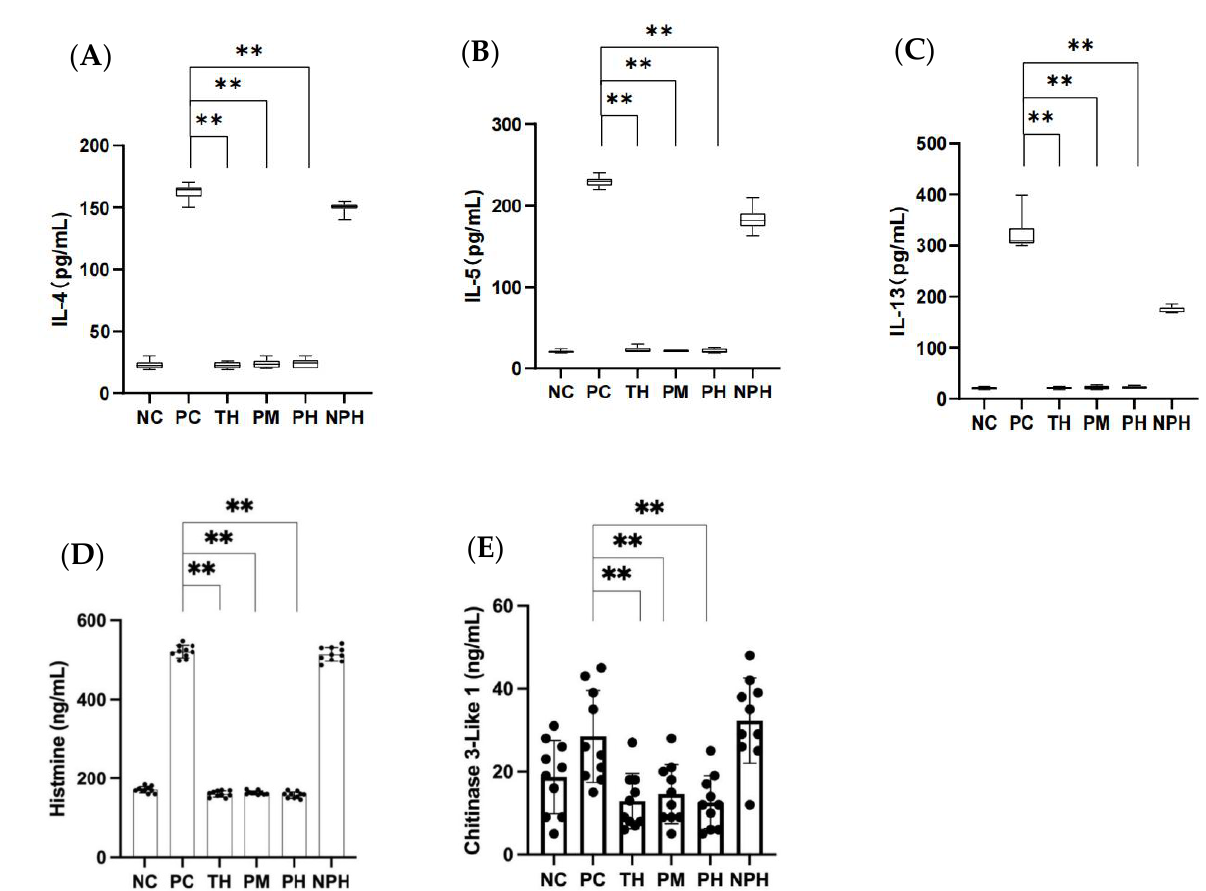
Figure 2. Contents of IL-4, IL-5, IL-13 ( A – C ), histamine ( D ) and chitinase-3-like protein 1 ( E ) in the mice of each group. ( A ) Corresponds to the level of IL-4; ( B ) corresponds to the level of IL-5; ( C ) corresponds to the level of IL-13; ( D ) corresponds to the level of histamine; ( E ) corresponds to the level of chitinase-3-like protein 1. Data are shown as the mean ± SEM (n = 10). ** means differs significantly ( p < 0.05). NC corresponds to normal saline negative control group; PC corresponds to β-lactoglobulin positive control group; TH corresponds to trypsin hydrolysate group; PM corresponds to protamex hydrolysate group; PH corresponds to papain hydrolysate group; NPH corresponds to neutrase protease hydrolysate group. The black dots represent data (n=10).